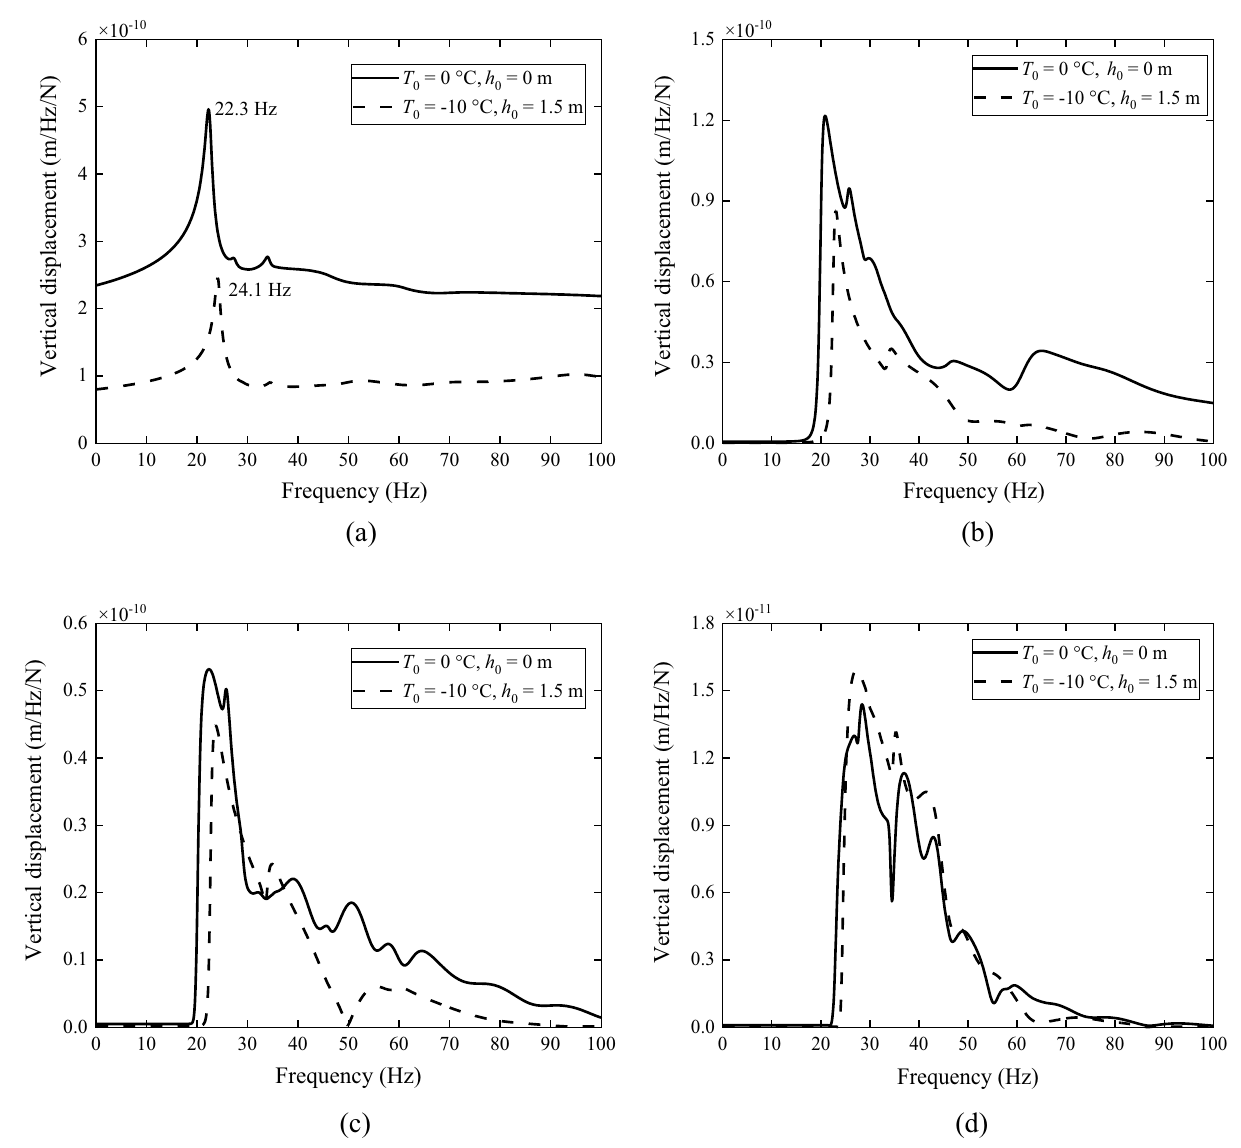
Figure 20. Spectra of the ground surface at ( a ) y = 0 m, ( b ) y = 5 m, ( c ) y = 15 m and ( d ) y = 20 m along y -axis due to a 40 Hz load moving along the x -axis at 100